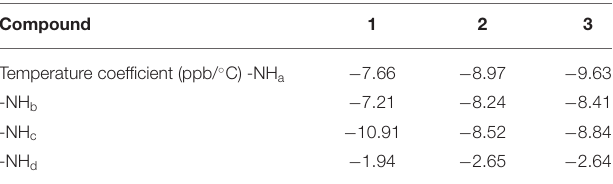
TABLE 1 | Temperature coefficients of –NH protons’ chemical shifts of 1 , 2 , and 3 in 90:10 (v/v) CD 3 CN/DMSO- d 6 mixtures. Compound 1 2 3 Temperature coefficient (ppb/ ◦ C) -NH